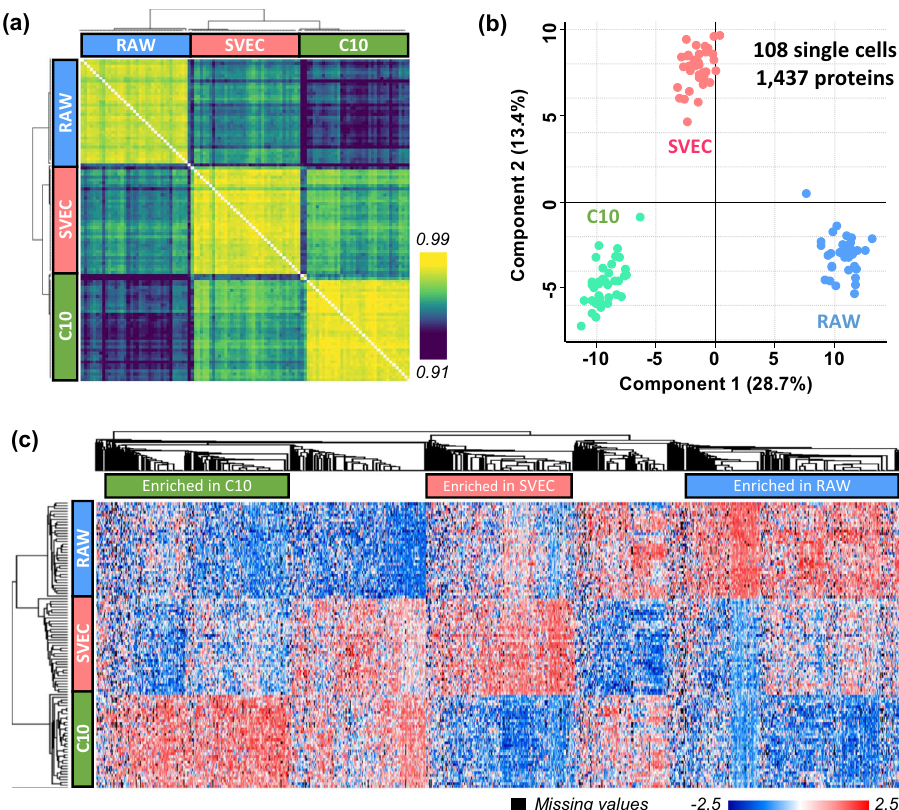
Fig. 4 Evaluation of quanti fi cation performance for single cells. a Clustering matrix showing Pearson correlations across 108 single cells using log2- transformed protein intensities. The color scale indicates the range of Pearson correlation coef fi cients. b PCA plot showing the clustering of single cells by cell types. Total 1437 proteins were used in the PCA projection. c Heatmap with hierarchical clustering showing 1127 signi fi cant proteins based on ANOVA test. Three protein clusters used for pathway analysis were labeled and highlighted. The color scale indicates the range of Z -score values. Source data are